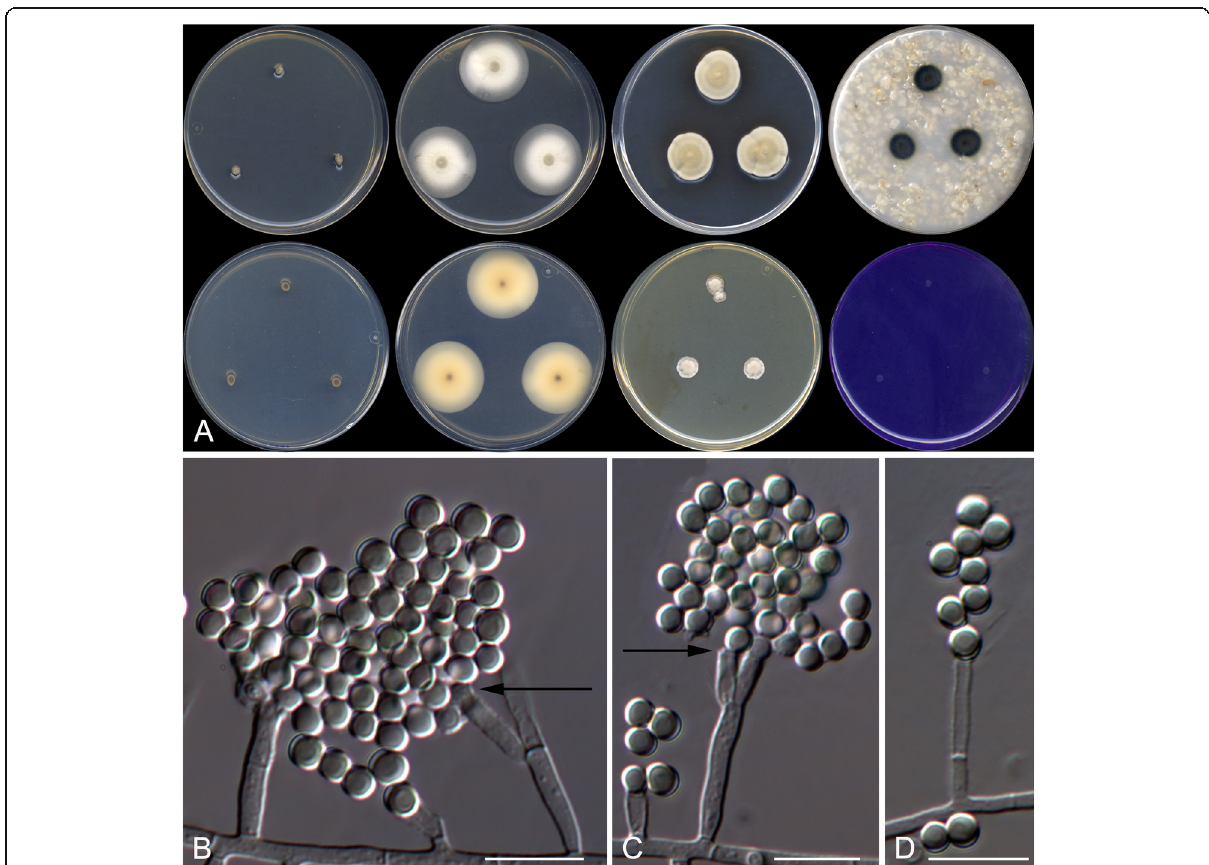
Fig. 9 Talaromyces affinitatimellis CBS 143840 T . a Colonies from left to right (top row) CYA, MEA, DG18 and OA; (bottom row) CYA reverse, MEA reverse, YES and CREA. b – d Conidiophores and conidia; the arrows shows the conidia formed basipetally. Scale bar = 10 μ